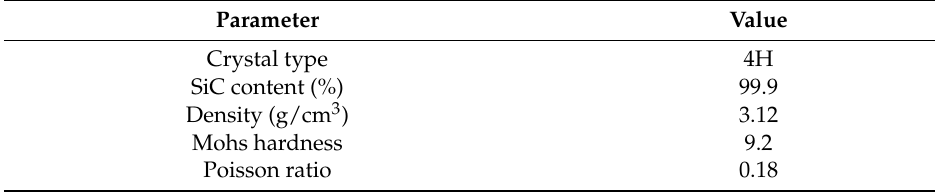
Figure 2. SRP experimental setup and its schematic. Table 1. SiC wafer material properties.